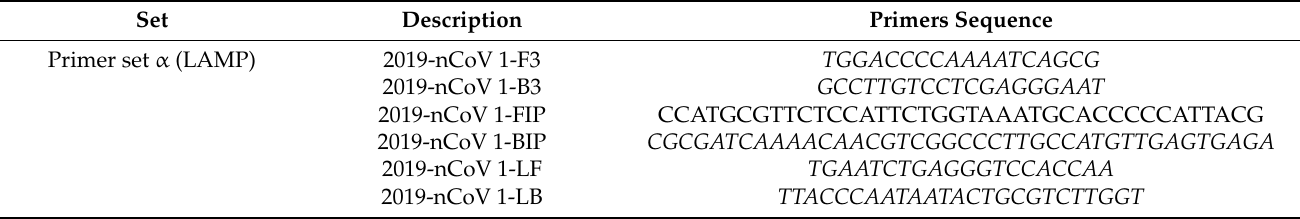
Table 1. Sequences of the Loop-mediated Isothermal Amplification (LAMP) primers used for the detection of segments of genetic material encoding for the expression of the N protein of SARS-CoV-2. Set Description Primer set α